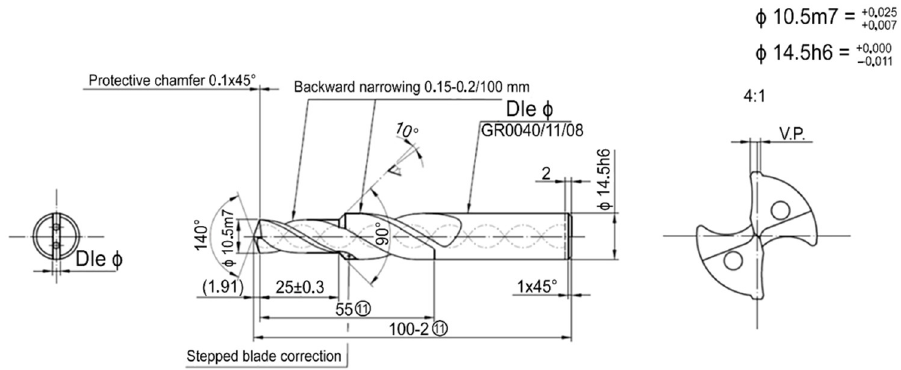
Figure 5. Pilot gun-drill tool Carbide 10.5/14.5 used in the experiment.